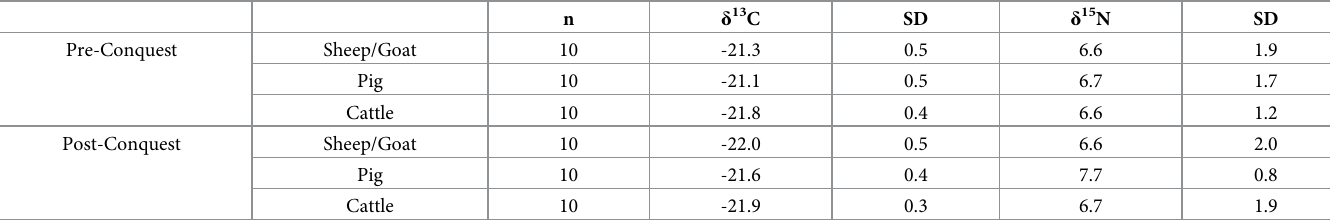
Table 2. Mean and standard deviation figures for δ 13 C and δ 15 N values for animal